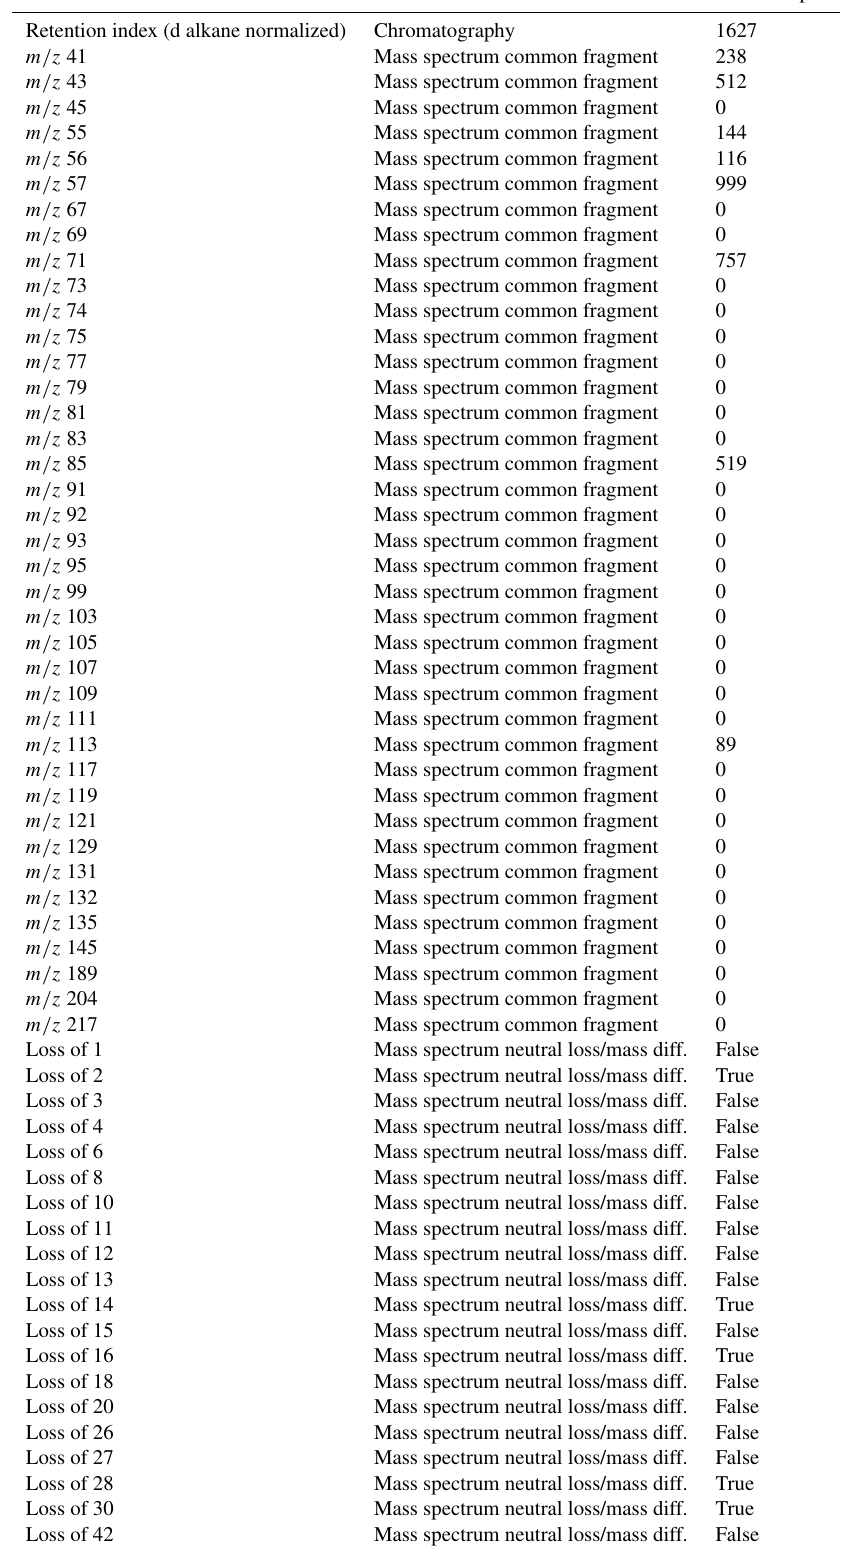
Table A4. Full chemical properties modeling features for